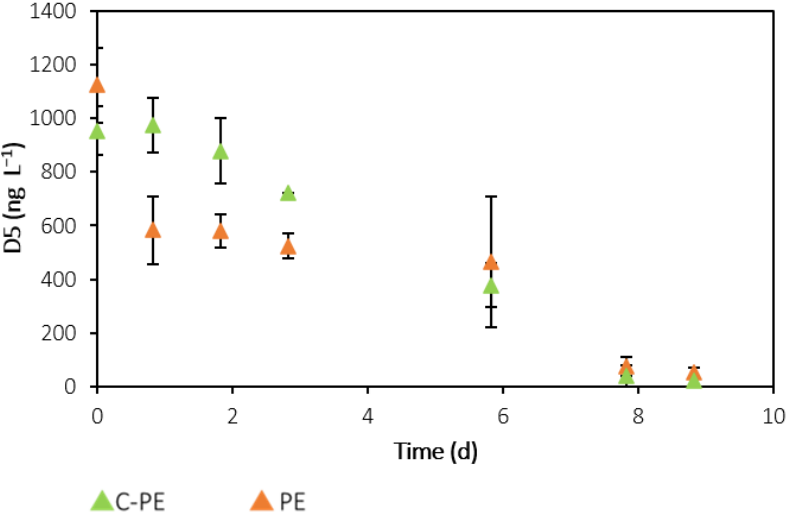
Figure 8. Time-course evolution of D5 concentration in the cell-free culture medium samples collected from C-PE and PE assays. Error bars correspond to the standard deviation of the mean obtained from two independent experiments.